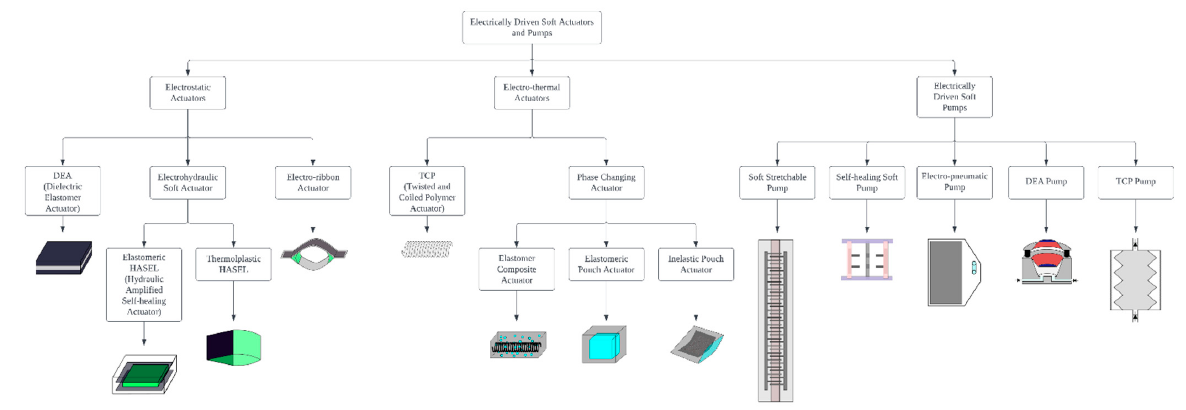
Figure 1. Figure showing different types of actuators being discussed in this review article.